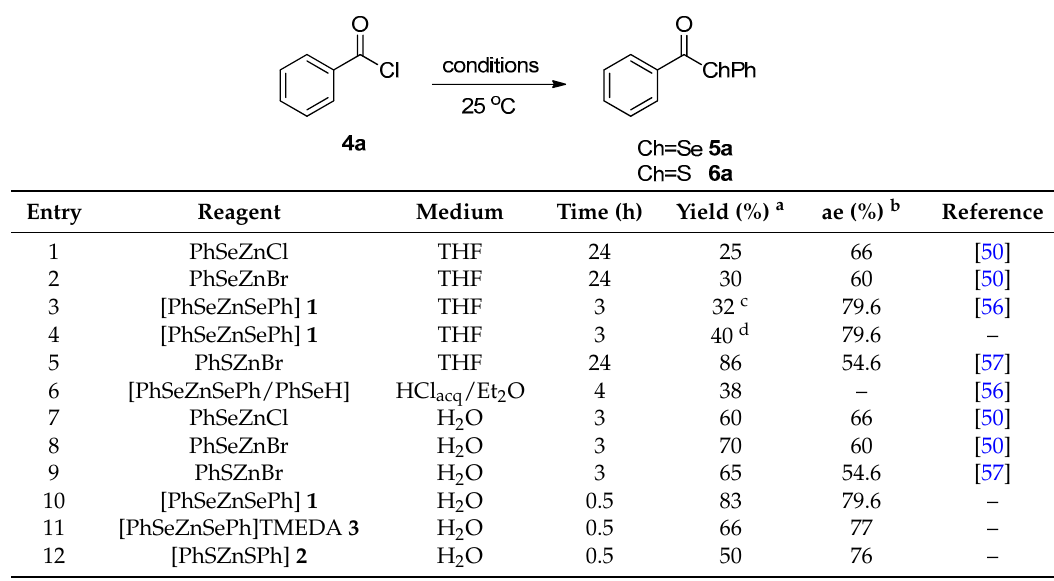
Table 2. Zinc chalcogenates 1 – 3 in the preparation of chalcogenol